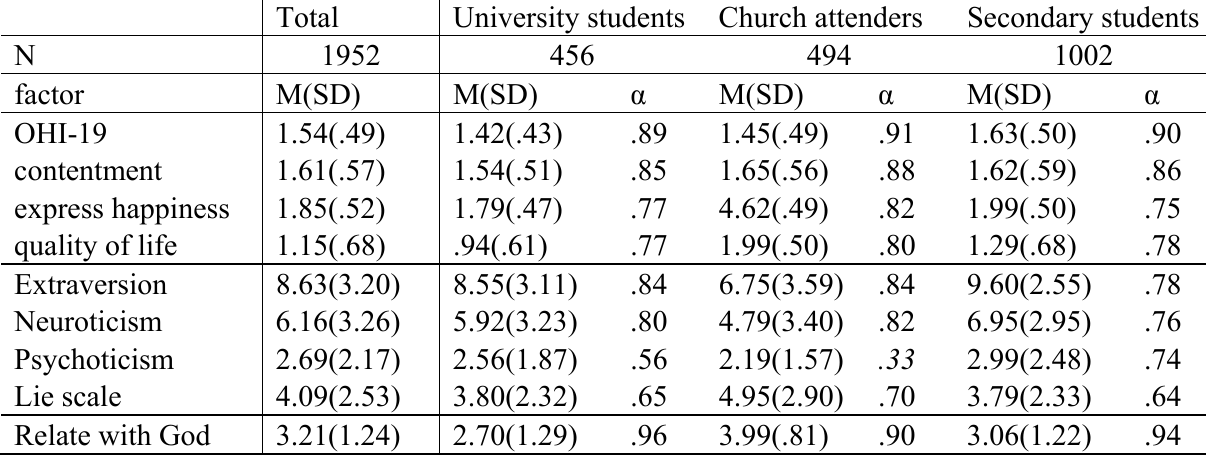
Table 1. Mean (SD) and α coefficients for factors on happiness, personality, and relating with